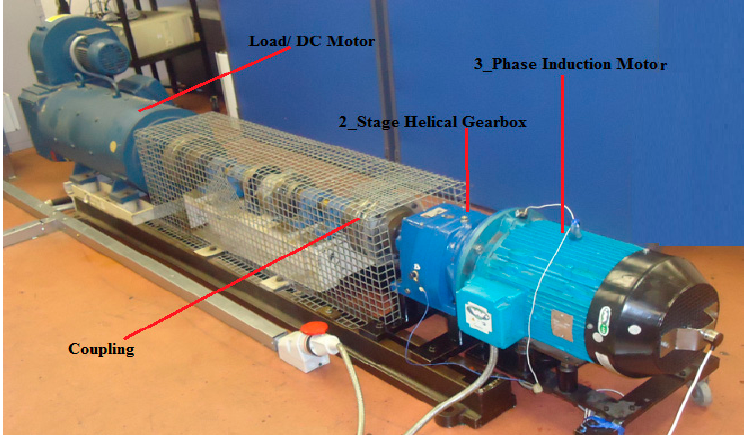
Figure 3. Rolling element bearing test rig.